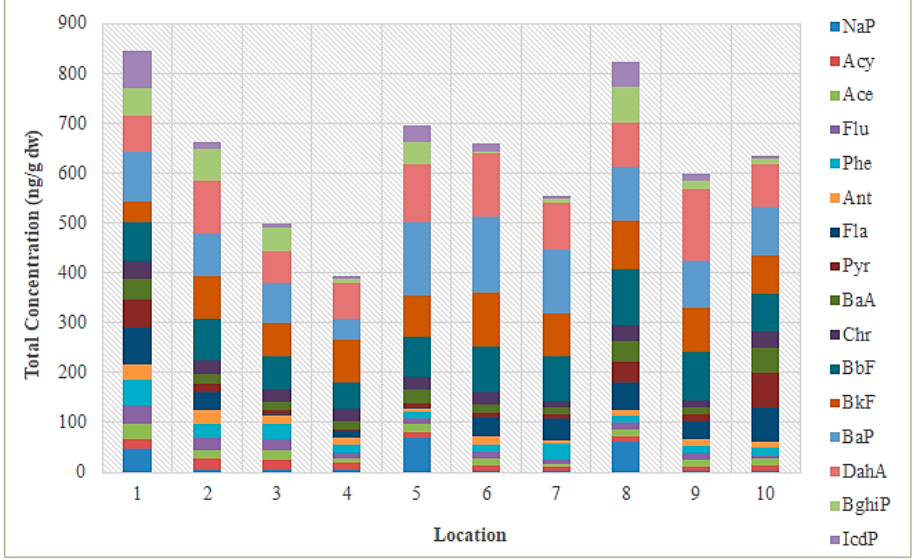
Figure 5. Concentrations of the 16 priority PAHs (ng/g dw) found in sediment samples from the Sele River at 10 sampling locations (April 2021).